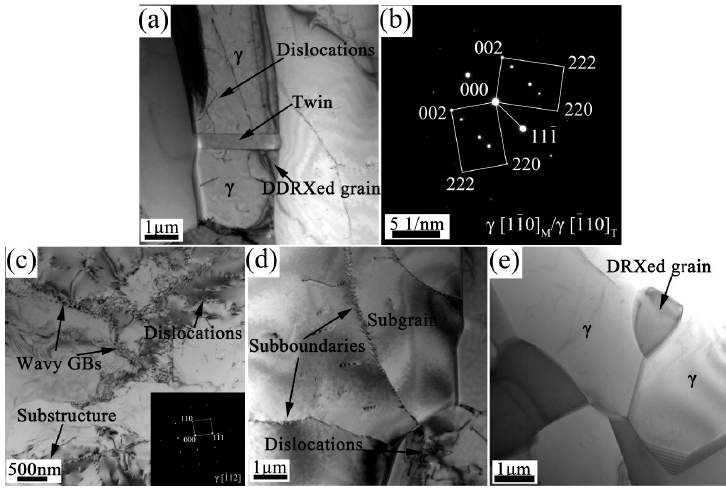
Figure 10. TEM images of the Ti-43Al-9V-0.2Y alloy sheet: ( a , b ) γ twins and corresponding SAD pattern; ( c ) High-density dislocations and substructures within the γ grain and SAD pattern of the γ phase; ( d ) γ sub-grains; ( e ) The recrystallized γ grains.